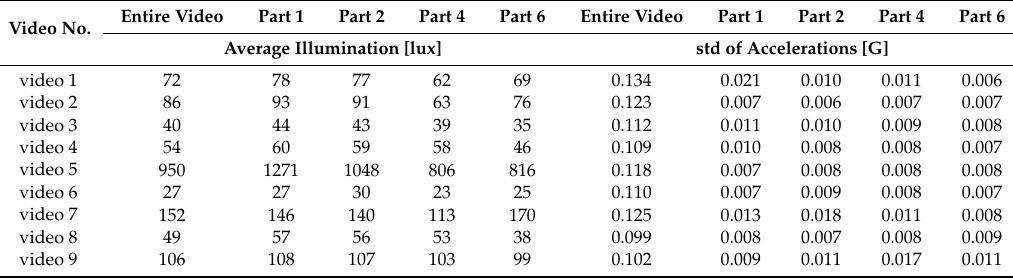
Table A2. The average illumination and standard deviation of accelerations for recorded video sequences and selected parts.